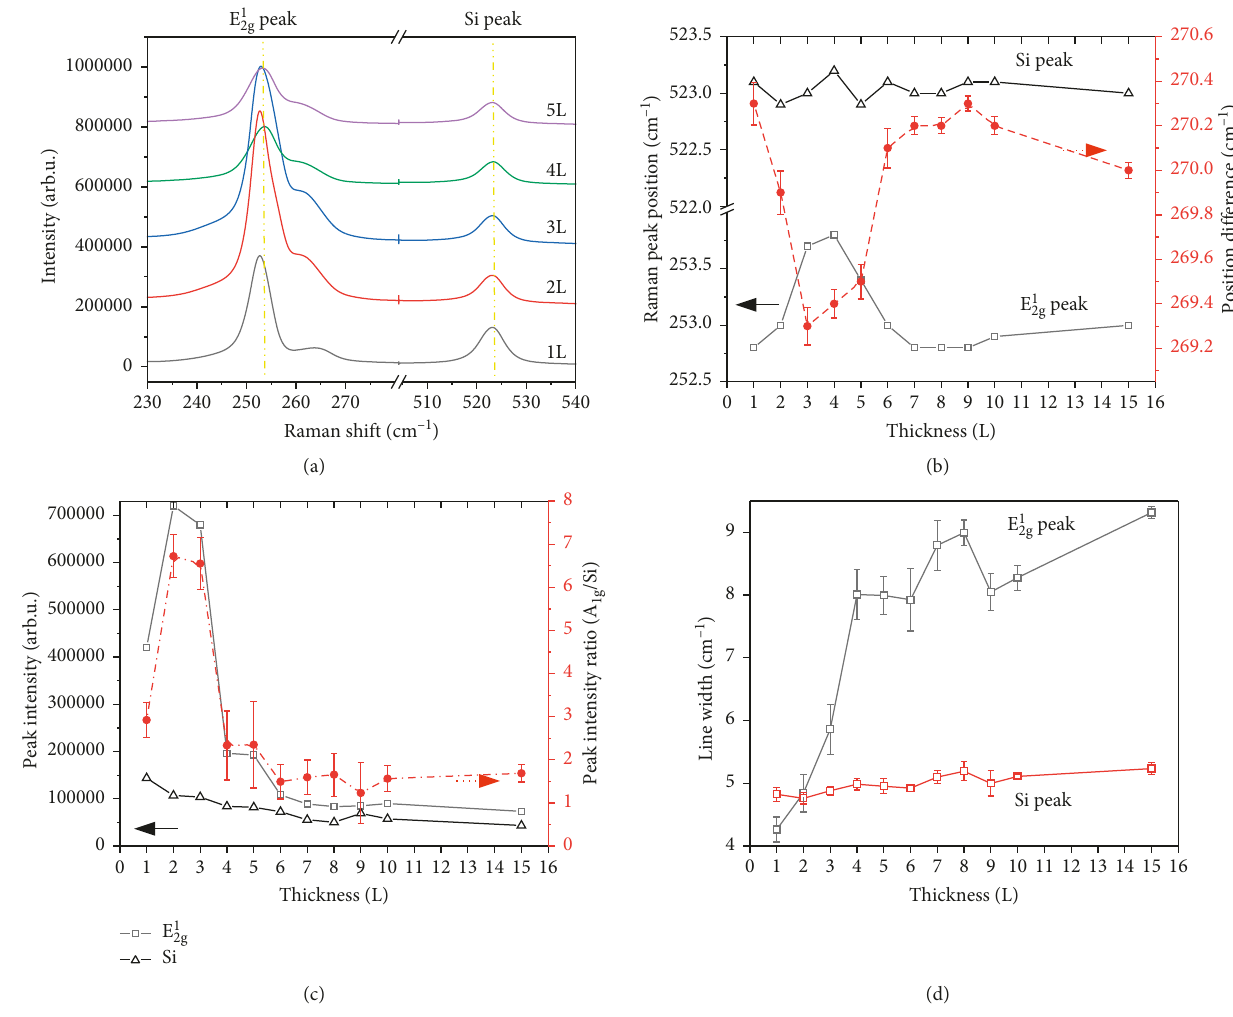
Figure 3: (a) Raman spectra of different layer numbers of WSe 2 supported by SiO 2 (285 nm)/Si substrate by 633 nm laser. (b) Raman peak peak and Si peak for different layer numbers (left vertical axis) and their difference (right vertical axis). (c) Raman position of WSe 2 ’s E 1 2g peak intensity of WSe 2 ’s E 1 peak and Si peak for different layer numbers (left vertical axis) and their ratio (right vertical axis). (d) Raman 2g peak and Si peak line width of WSe 2 ’s E 1 2g